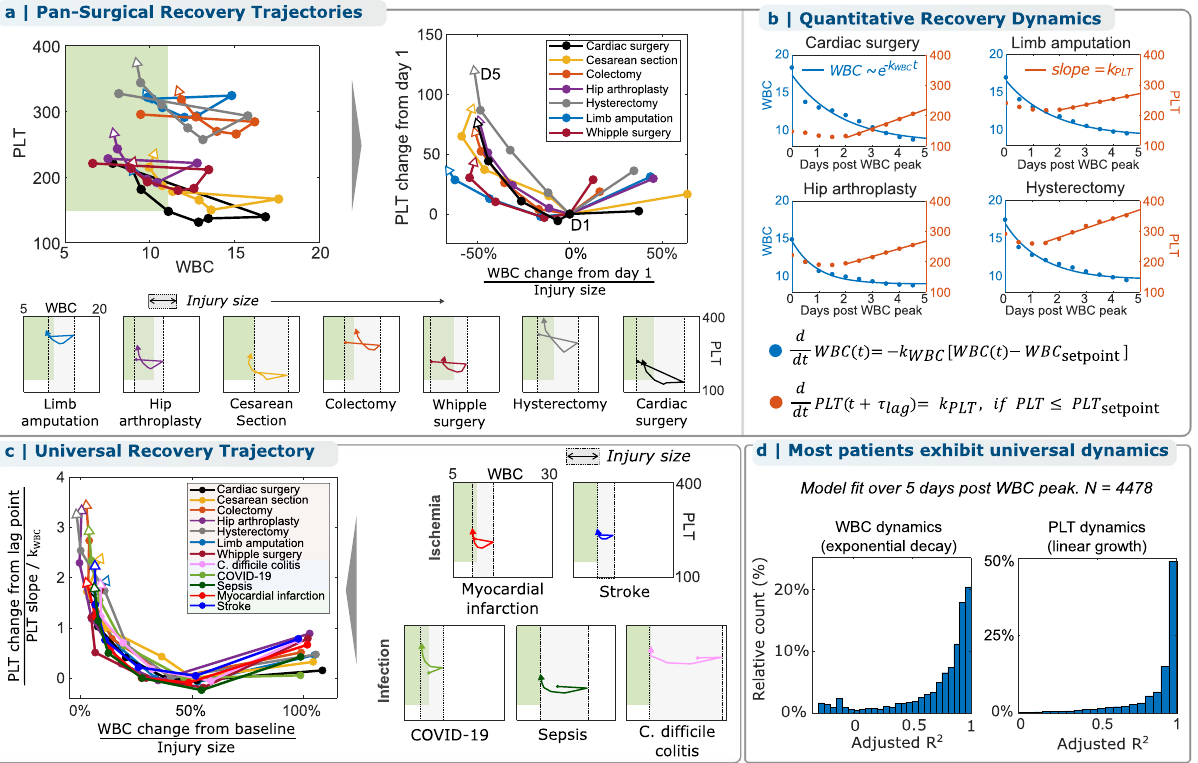
Fig. 2 | The WBC-PLT recovery shape is conserved across multiple types of physiologic responses to all studied in fl ammatory stimuli share the same char- traumatic, infectious, and ischemic in fl ammatory stimuli and demonstrates acteristic features. d Most patients with good outcomes follow trajectories well- exponentialWBC decayand linearPLT growth. a Six additional types of surgery approximated by this model,with medianmodel fi ts(adjustedR 2 )of 0.85 and 0.95 forWBCsandPLTs.SeeSupplementaryFig.15formodel fi tsfortheother8cohorts areassociatedwithasimilaraverageshapeofWBC-PLTrecovery. b WBC dynamics and Supplementary Fig. 7 for fi tted model parameters ( k WBC , k PLT ), for all cohorts. arewell-approximatedassimpleexponentialdecayfromamaximumWBC,andPLT Source data are provided as a Source data fi le. WBC: white blood cell count, PLT: days after the maximum WBC. dynamics as linear growth starting τ PLT delay c Infectious and ischemic in fl ammatory stimuli demonstrate the same average platelet WBC-PLT recovery shape, and a non-dimensionalized 17 model shows that